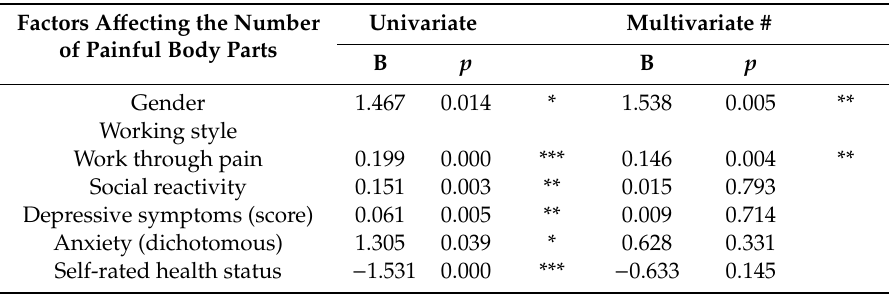
Table 3. Univariate and multivariate regression model studying factors a ff ecting the number of body parts with WRMSs at baseline (T0).